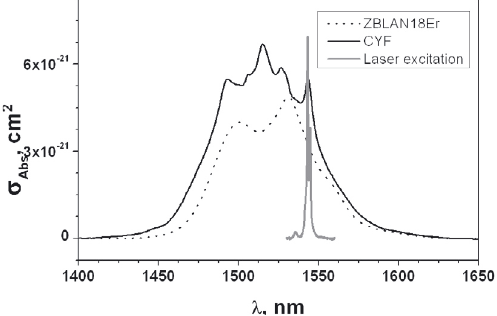
Fig. 3. Er 3+ fundamental absorption ( 4 I 15 / 2 → 4 I 13 / 2 ) for both studied materials and the laser excitation.